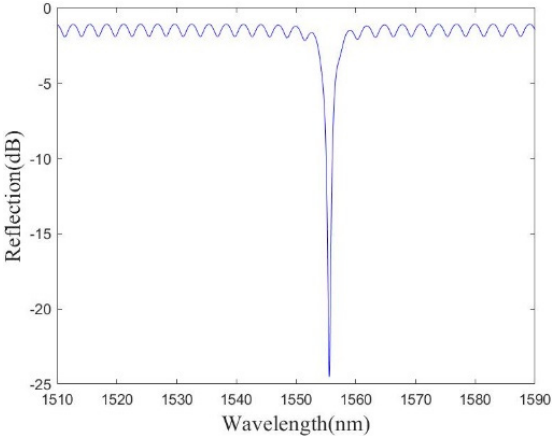
Figure 2. Simulation of multi-beam interference spectrum.